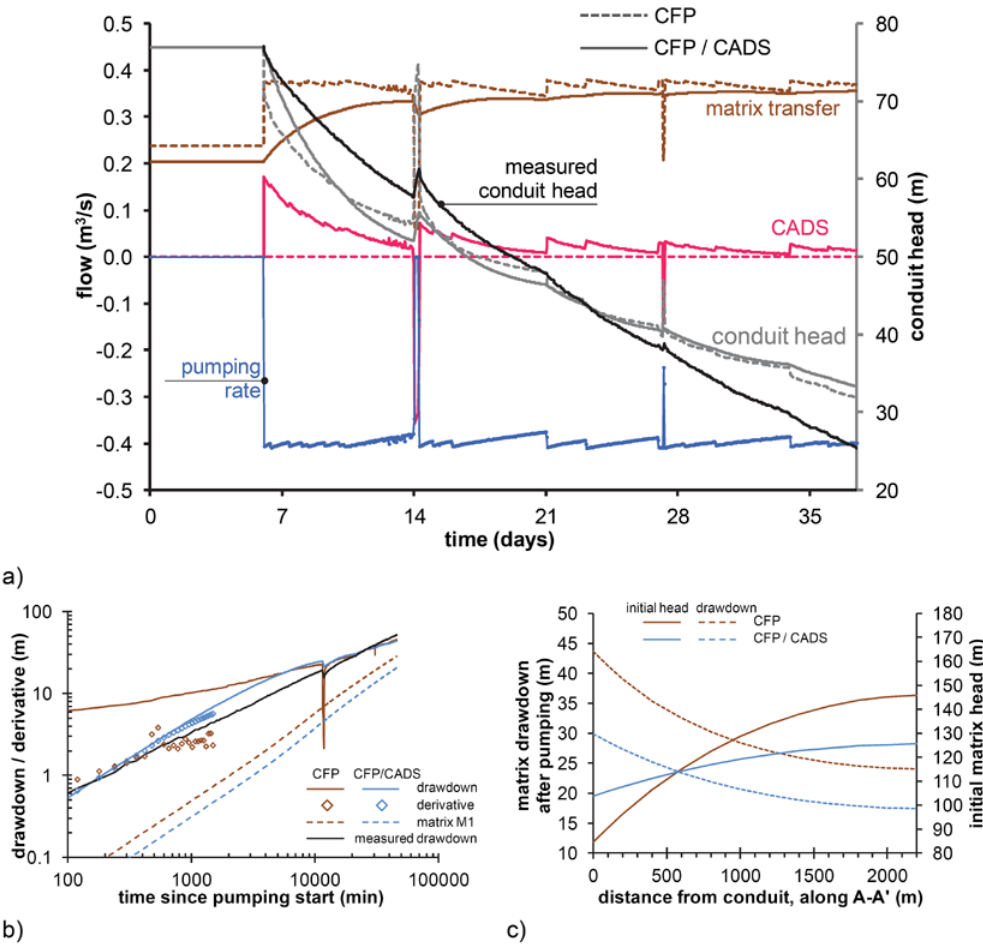
Fig. 11. Simulation results for the large-scale pump test scenario: (a) flow terms and conduit heads computed with CFP and CFP/CADS; (b) computed drawdown in both conduit (solid lines) and matrix (dashed lines) for the basic situation with drawdown derivatives (symbols) computed according to Eq. (12); (c) computed drawdown in the conduit for varying CADS width and water transfer